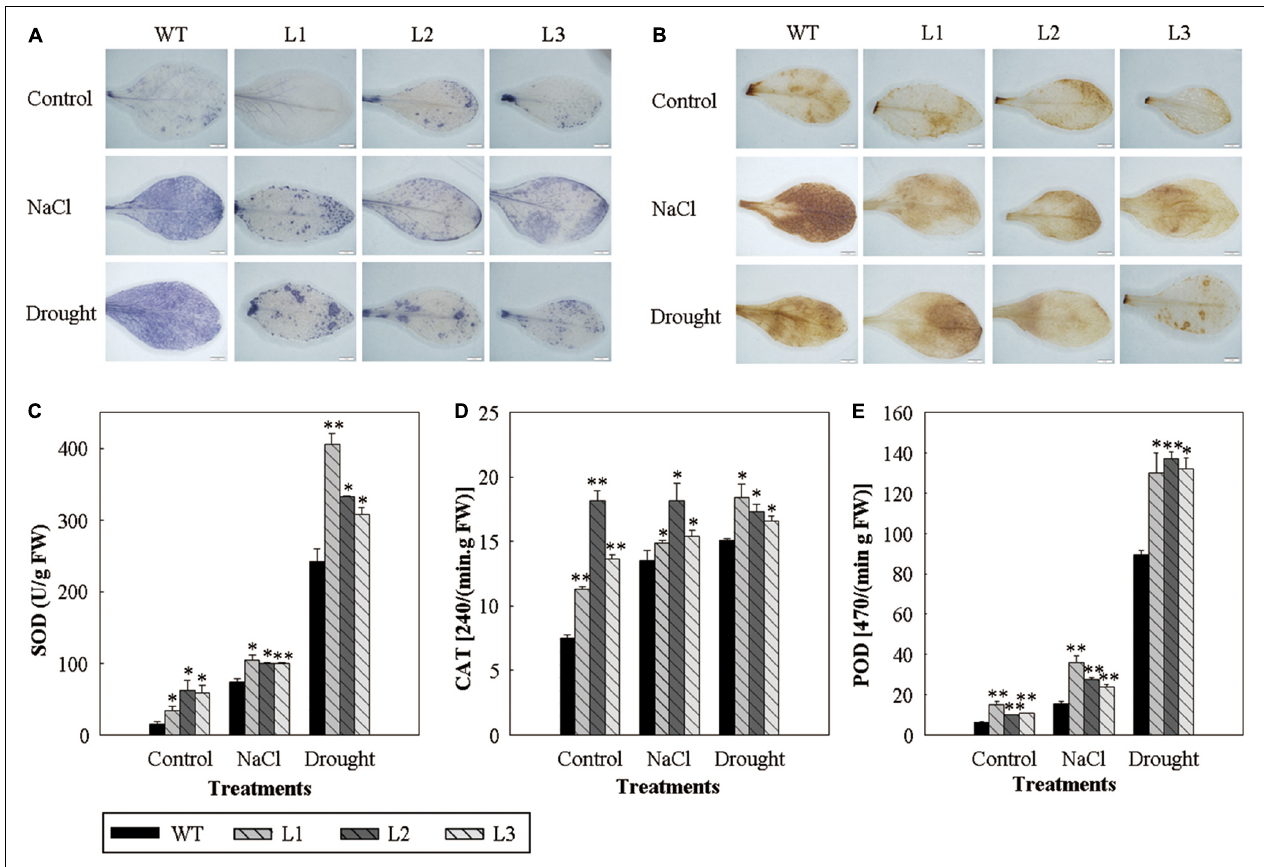
FIGURE 4 | Reactive oxygen species levels and activity assays of activated oxygen scavenging enzymes in WT and VlWRKY3 transgenic Arabidopsis thaliana plants under normal growth and abiotic stress conditions. (A,B) Histochemical staining assay of O 2 - and H 2 O 2 accumulation with NBT (A) and DAB (B) , in WT and transgenic leaves following normal growth and abiotic stress conditions. The experiment was repeated 3 times, and 5–10 leaves were stained in each experiment. (C–E) Activity of SOD (C) , CAT (D) and POD (E) in the leaves of WT and transgenic plants under normal growth and abiotic stress conditions. Data values represent means ± SD from three independent experiments. Asterisks indicate statistical significance ( ∗ 0.01 < P < 0.05, ∗∗ P < 0.01, Student’s t -test) of differences between transgenic lines and WT